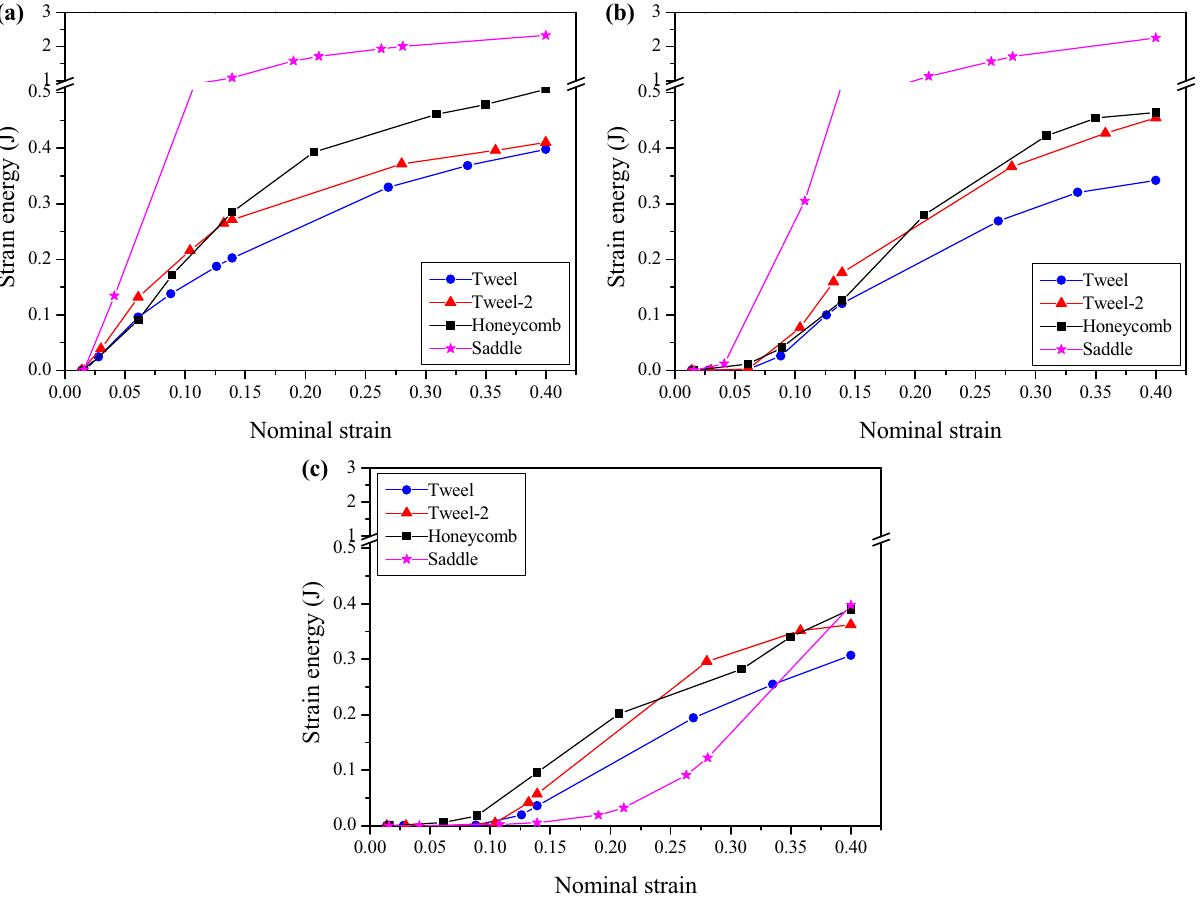
Figure 9: Strain energy stored in spoke, obtained from the FE models: ( a ) No. 1, ( b ) No. 2, and ( c ) No.